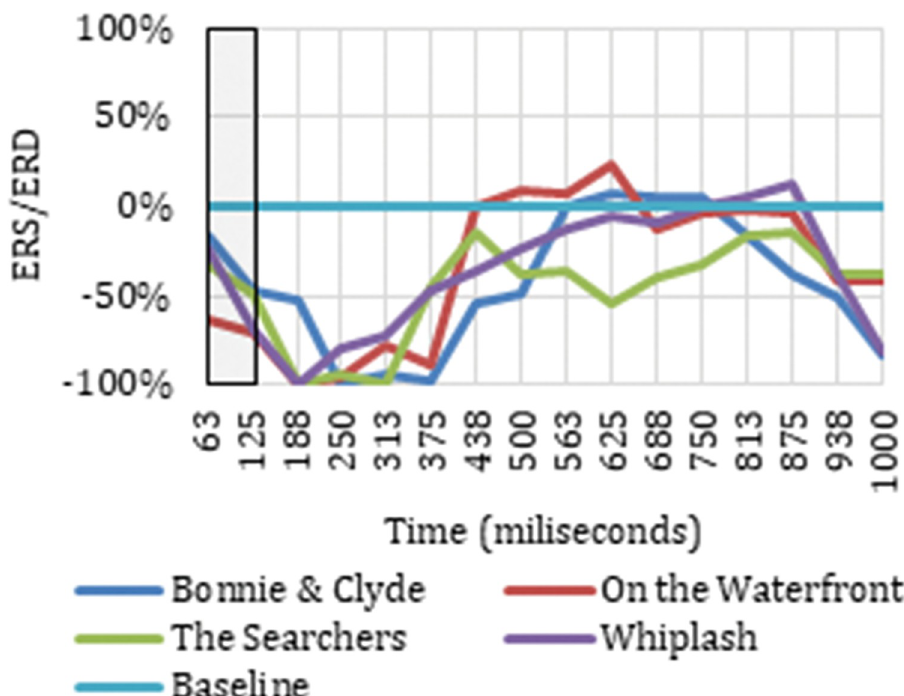
Fig 13. ERD/ERS from all four film excerpts for Pz electrode in